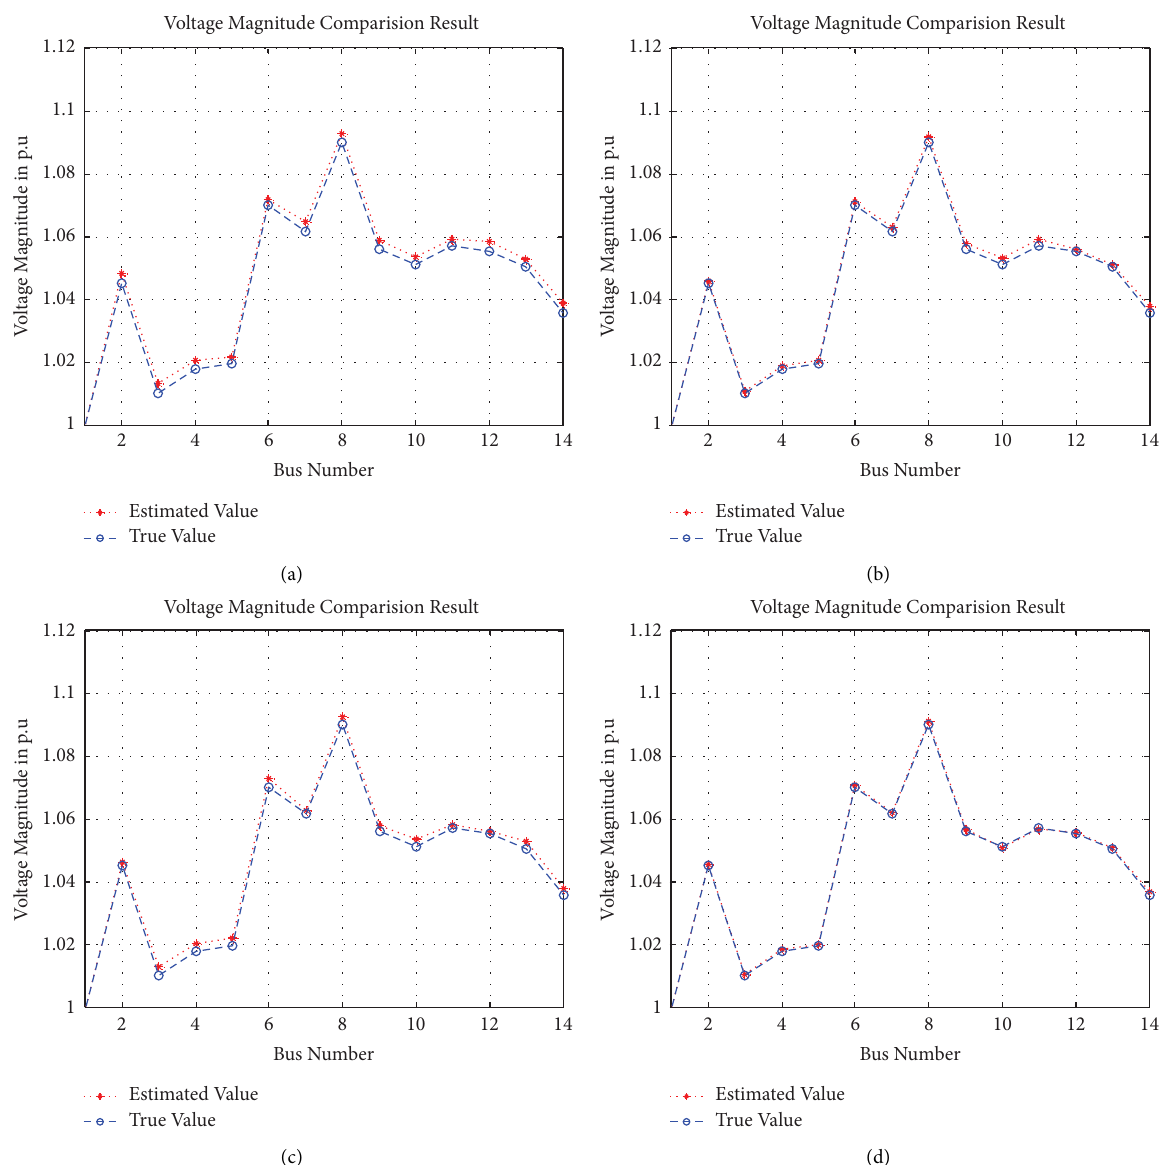
Figure 4: Comparison of true and estimated values for the magnitude of bus voltage in the 14-bus network by performing scenarios 7 and 8 assuming Gaussian and non-Gaussian noise measurements. (a) Magnitude of busbars voltage—scenario 7 non-Gaussian noise. (b) Magnitude of busbars voltage—scenario 7 Gaussian noise. (c) Magnitude of busbars voltage—scenario 8 non-Gaussian noise. (d) Magnitude of busbars voltage—scenario 8 Gaussian